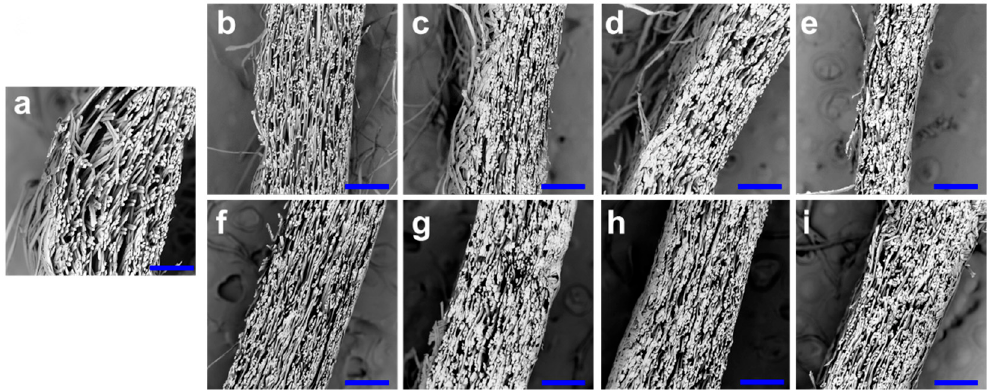
Figure 3. SEM images of cocoon cross-section structures. ( a ) Normal cocoon; ( b ) PT-25 cocoon; ( c ) PT-20 cocoon; ( d ) PT-14 cocoon; ( e ) PT-12 cocoon; ( f ) CB-20 cocoon; ( g ) CB-17.5 cocoon; ( h ) CB-15 cocoon; ( i ) CB-12.5 cocoon. Scale bar: 300 μ m.